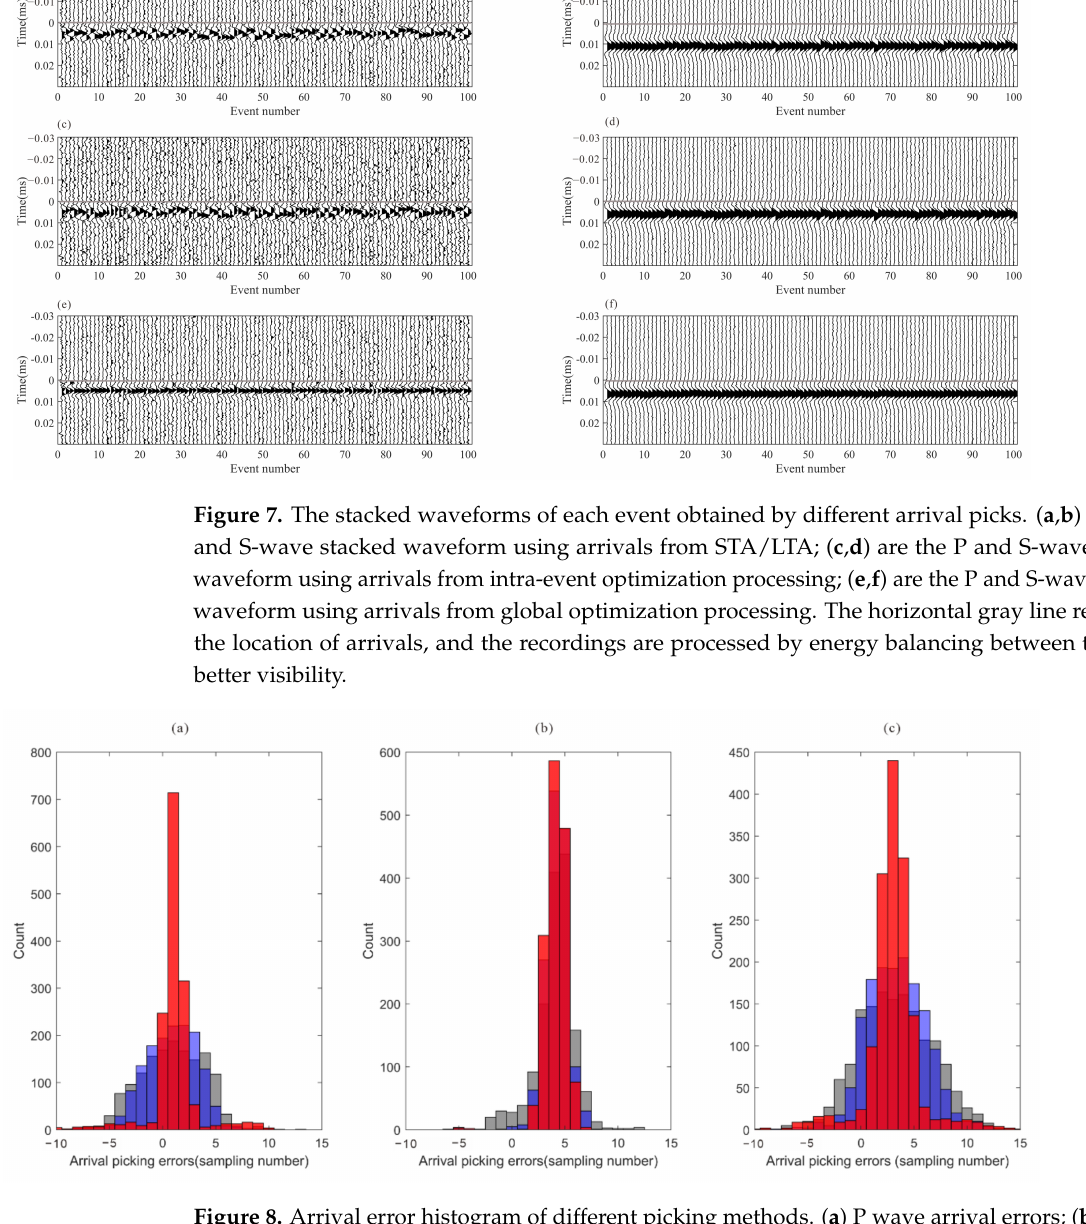
Figure 8. Arrival error histogram of different picking methods. ( a ) P wave arrival errors; ( b ) S wave arrival errors; ( c ) P-S time difference errors. The gray, blue, and red bars represent true arrivals and the arrivals of the STA/LTA method, the intra-event optimization processing method, and the inter-event optimization processing methods,